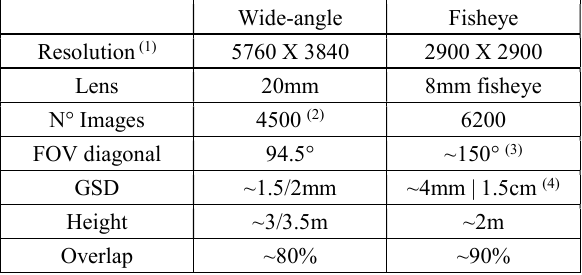
Table 1. Specs of the two methods: (1) resolution of used image area, (2) hypothesis supposing to cover the same area, (3) FOV of the used image circle, (4) GSD values refers to the centre of the frame and an estimate average over the used area.